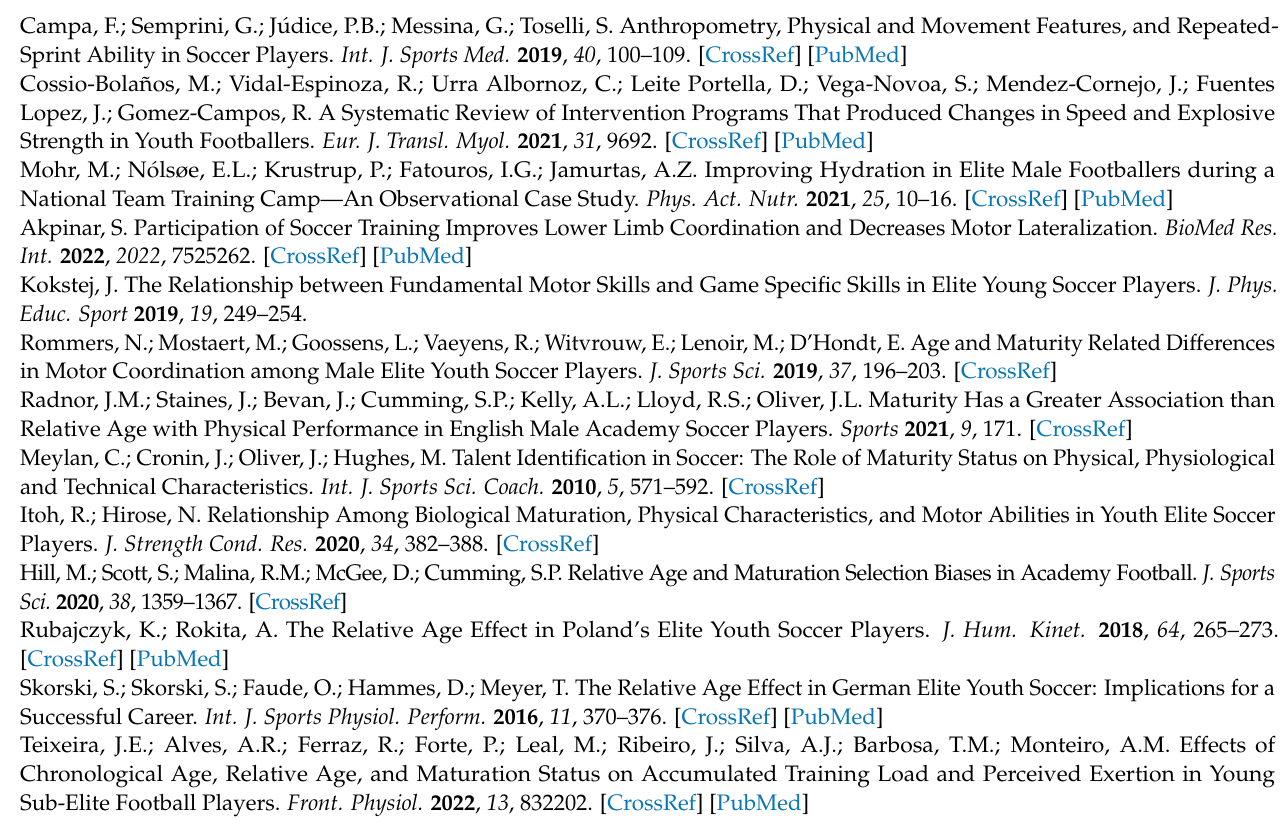
soccer players; Figure S1: BIVA tolerance with Maturity Status (top) and Relative Age Effect (bottom) of both Bologna and Russi U12 groups for Italian SERIE A reference populations (number 20, Serie A Micheli). Note: U15 Bo and U15 Ru refer to team means respectively; Figure S2: BIVA tolerance with Maturity Status (top) and Relative Age Effect (bottom) of both Bologna and Russi U13 groups for Italian SERIE A reference populations (number 20, Serie A Micheli). Note: U15 Bo and U15 Ru refer to team means respectively; Figure S3: BIVA tolerance with Maturity Status (top) and Relative Age Effect (bottom) of both Bologna and Russi U14 groups for Italian SERIE A reference populations (number 20, Serie A Micheli). Note: U15 Bo and U15 Ru refer to team means respectively; Figure S4: BIVA tolerance with Maturity Status (top) and Relative Age Effect (bottom) of both Bologna and Russi U15 groups for Italian SERIE A reference populations (number 20, Serie A Micheli). Note: U15 Bo and U15 Ru refer to team means